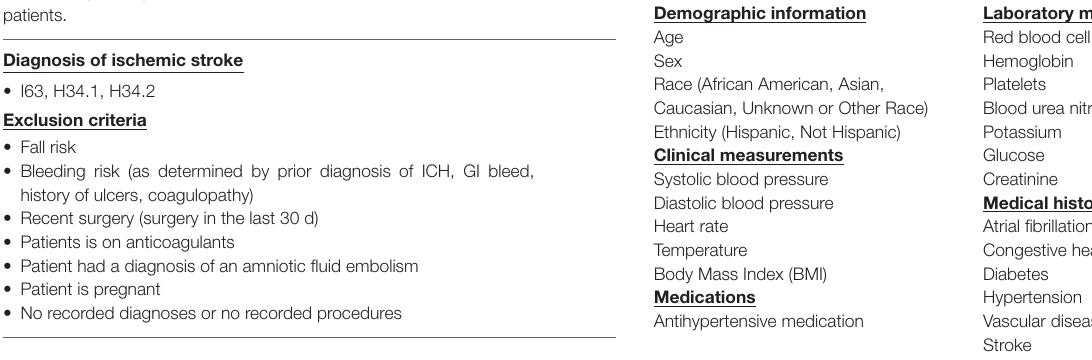
TABLE 1 | Inclusion and exclusion details. International classification of diseases version 10 (ICD-10) codes were used to determine inclusion of ischemic stroke patients.